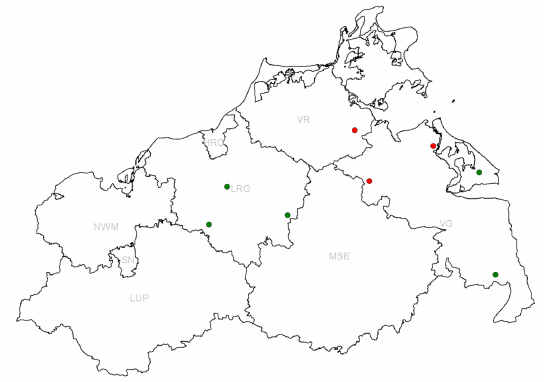
Figure 1. Location of sampled farms in the federal state of Mecklenburg-Western Pomerania. Con- ventional fattening farms are depicted in red and organic ones in green. The district names are indicated in light gray (HRO = Hansestadt Rostock, LRO = Rostock-Land, LUP = Ludwigslust- Parchim, MSE = Mecklenburgische Seenplatte, NWM = Nordwest-Mecklenburg, SN = Schwerin, VG = Vorpommern-Greifswald, VR =